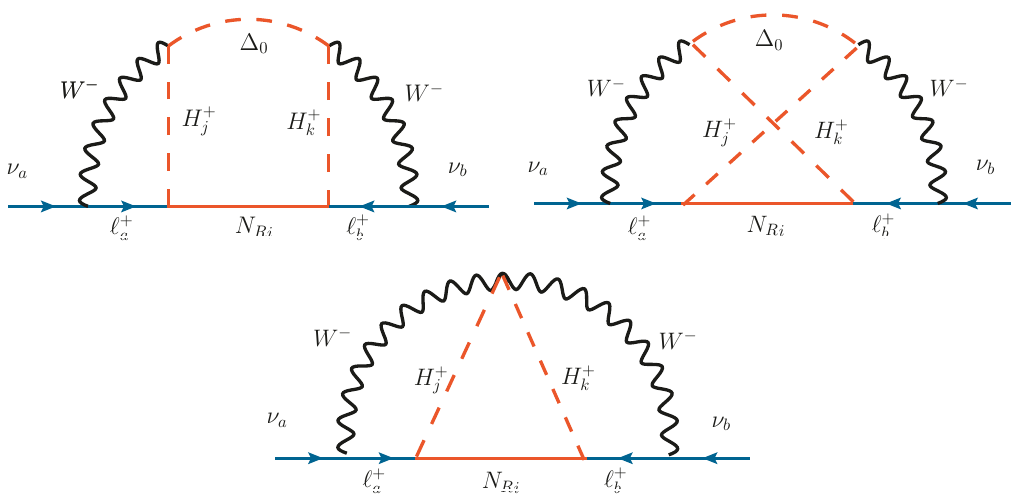
Figure 8 . Three-Loop neutrino mass diagrams for Model 1 ( S and (cid:31) being SU(2) L singlets) within Class 2 . BSM propagators are depicted in